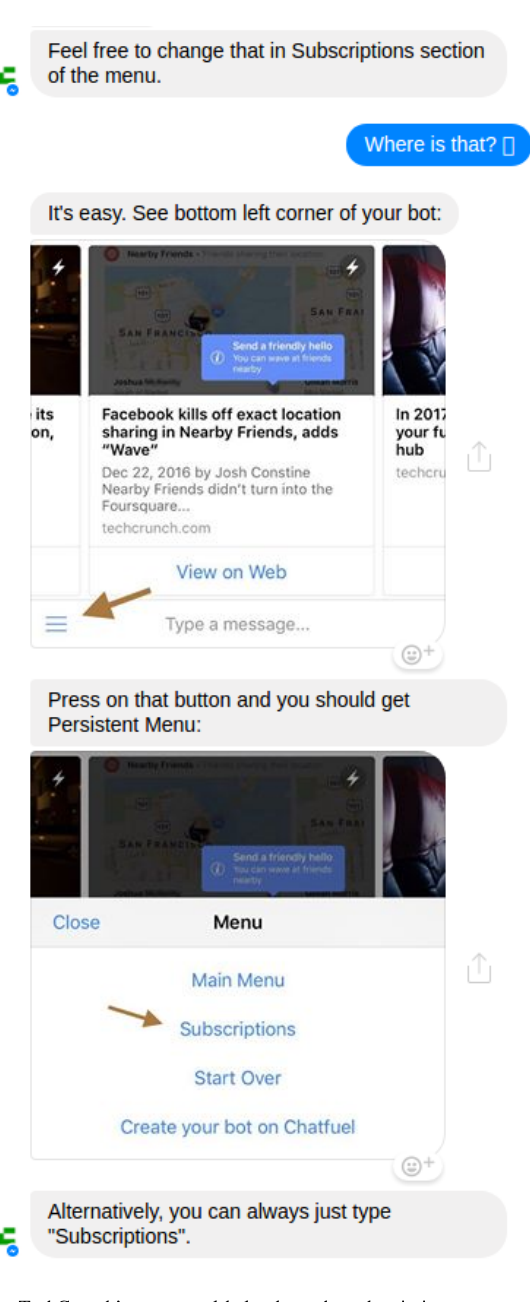
Fig. 16. TechCrunch’s contextual help about the subscriptions menu.